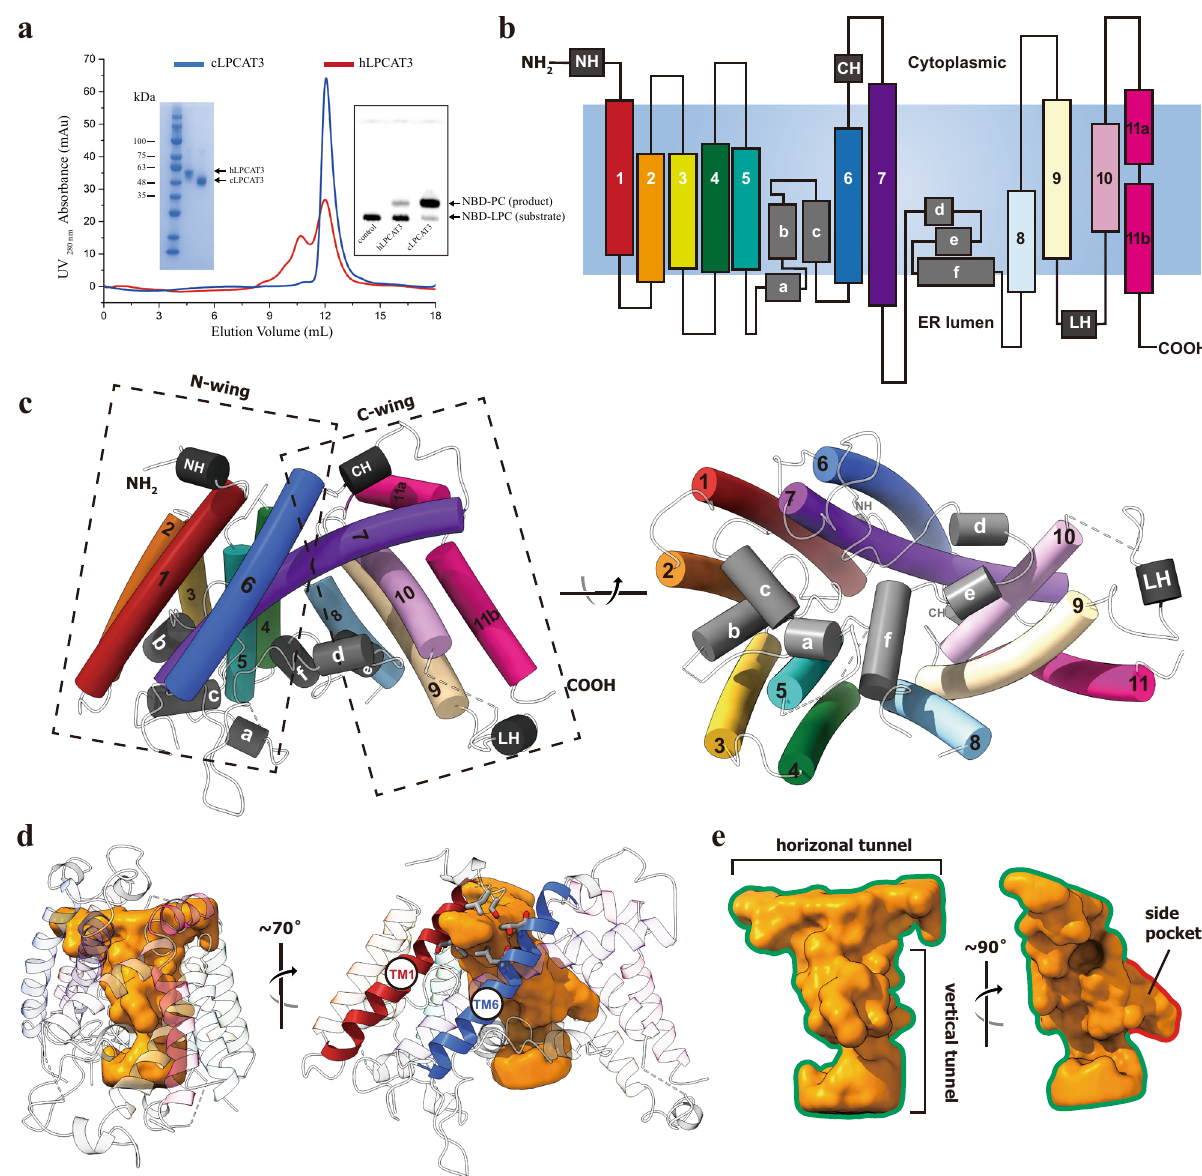
Fig. 1 The crystal structure of monomeric cLPCAT3. a The puri fi cation and functional assay of human and chicken LPCAT3. Blue and red curves show the size-exclusion chromatography pro fi les of the chicken and human LPCAT3 protein, respectively. The left inset shows the SDS-PAGE analysis on the fractions collected from the size-exclusion chromatography. The right inset shows the TLC assay on the enzymatic activities of the fractions. The experiment has been repeated three times with success. b Cartoon representation of cLPCAT3 monomer topology. The TM helices 1 – 11, N-terminal helix NH, membrane-embedded helices a-f, the cytoplasmic helix CH, and the lumenal helix LH were colored according to the same scheme as in ( c ). The cell membrane was shown as steel gray block and the orientation labeled according to the calculation using PPM server (https://opm.phar.umich.edu/ ppm_server). c Left: the cLPCAT3 molecular model viewed parallel to the ER membrane; Right: the cLPCAT3 molecular model viewed from the lumen side of the ER membrane. d The T-shape chamber of cLPCAT3. The internal cavity within cLPCAT3 as determined by program HOLLOW was shown as surface in golden and the cLPCAT3 was shown as the cartoon model, with the lateral gate-forming helices TM1 and TM6 in red and blue, respectively. e A close view of the T-shape chamber. All structure graphs in this and the following fi gures were generated with PyMOL (The PyMOL Molecular Graphics System, Version 1.9 Schrödinger, LLC.) and UCSF ChimeraX (The UCSF Resource for Biocomputing, Visualization, and Informatics, version